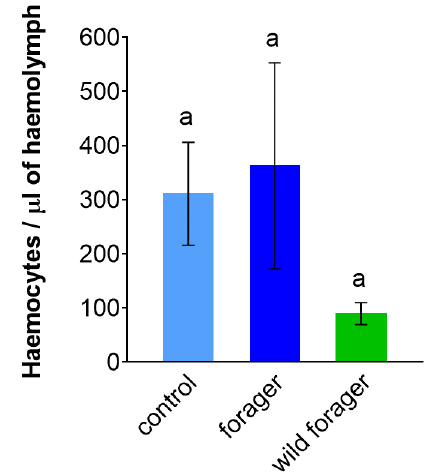
Figure 2. The concentration of circulating hemocytes determined in the hemolymph of non-foraging control, foraging and wild Bombus terrestris ( n = 3 – 4; five animals per biological replicate which means at least 15 bumble bee workers per each group). Data presented as mean ± SD; significant differences p < 0.05 are indicated by different letters above the columns (Tu key’s test).